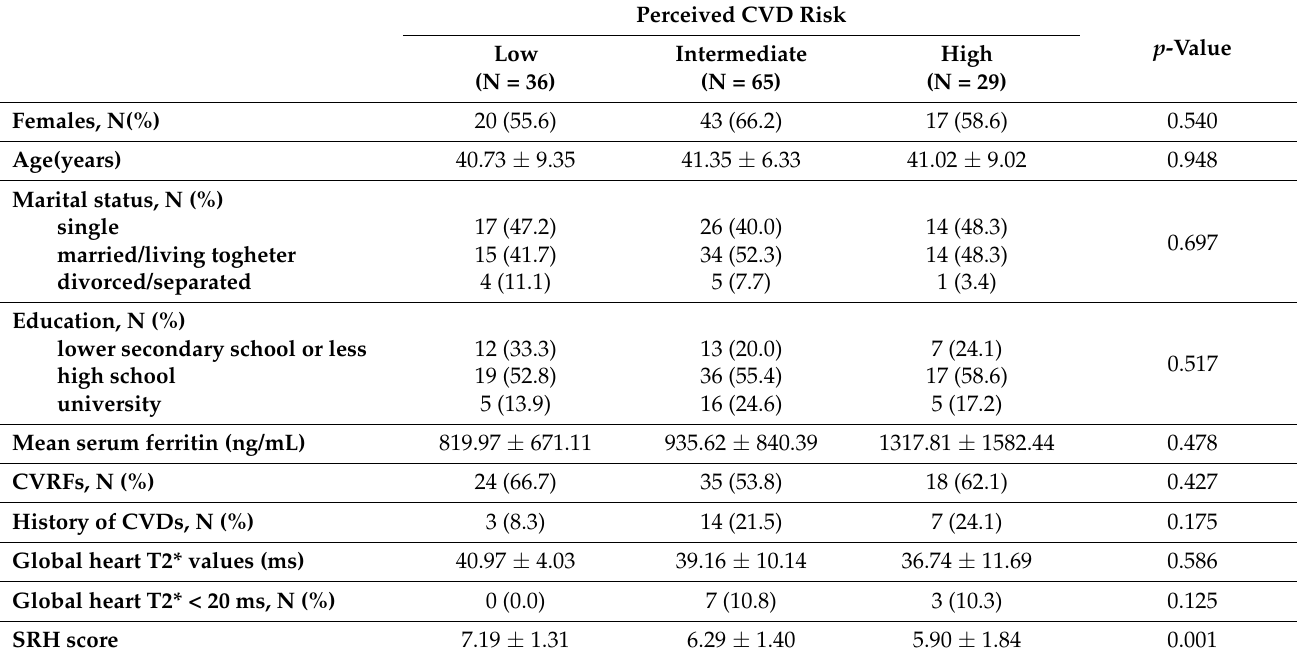
Table 5. Perceived heart disease risk versus demographics and clinical